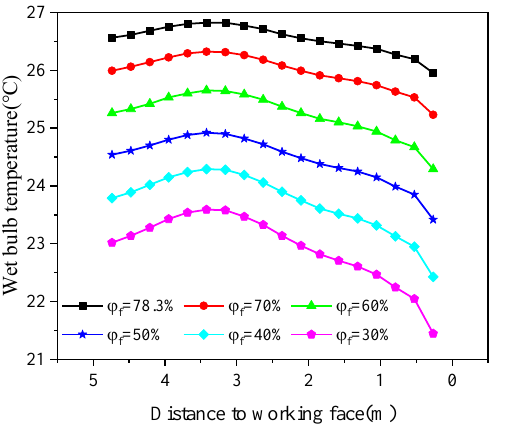
Figure 14. Wet bulb temperature distribution of drift centerline under different supply air humidity.